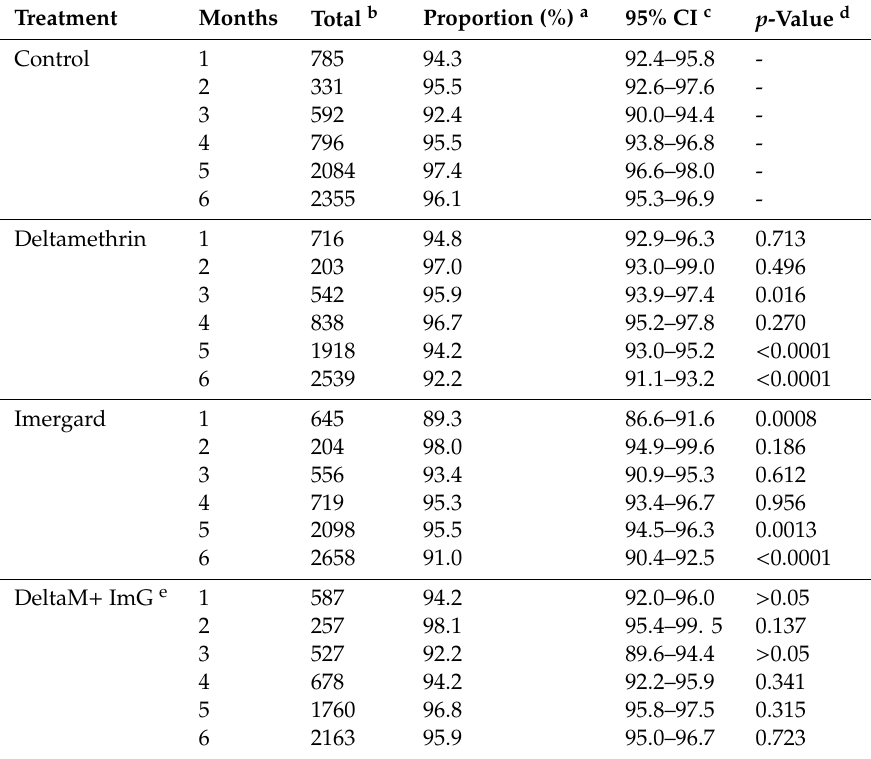
Table 3. Blood-feeding rates a of wild-type An. gambiae (s.l.) collected in the huts.